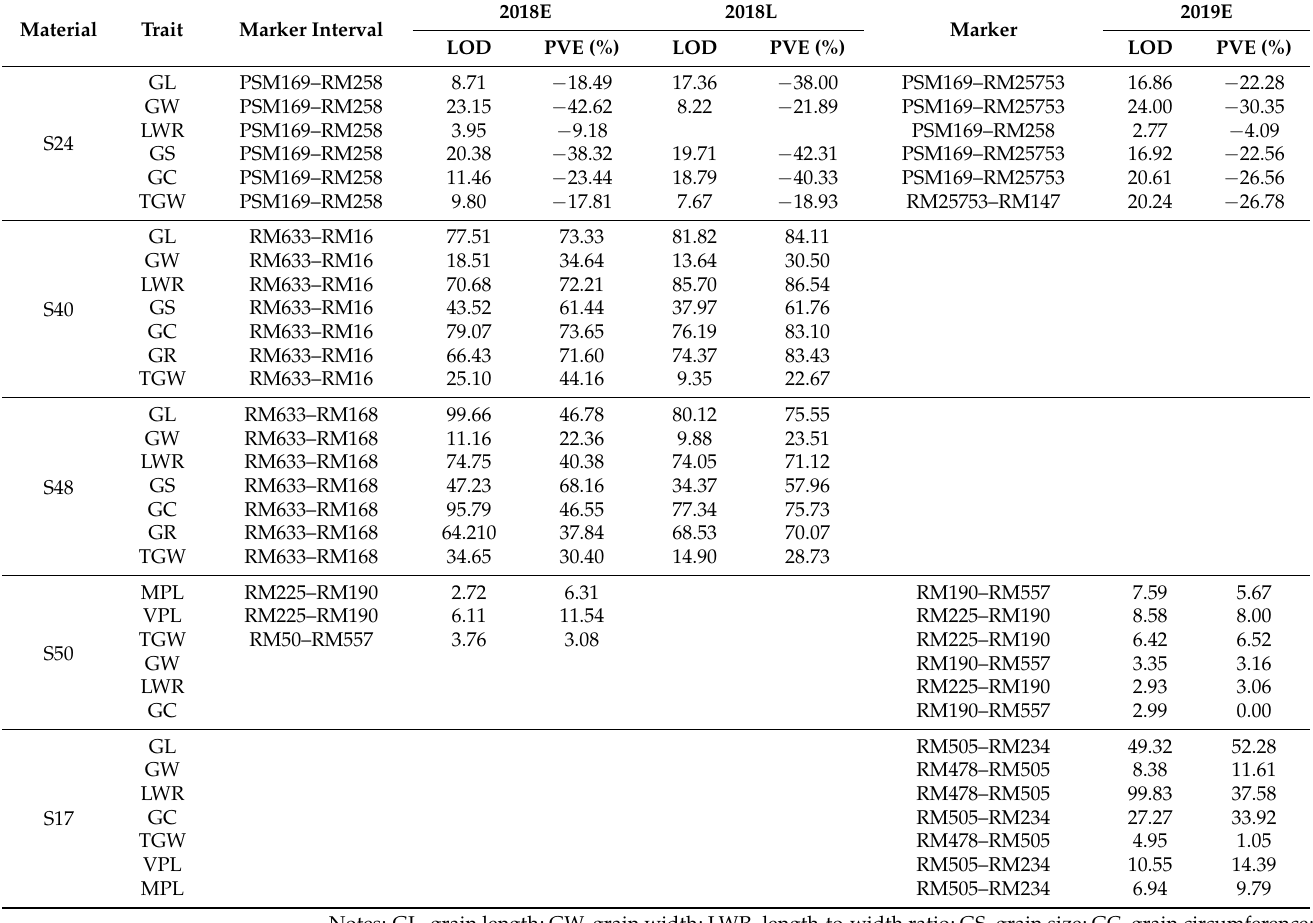
Table 3. QTL linkage analysis of important grain shape traits (n = 224).